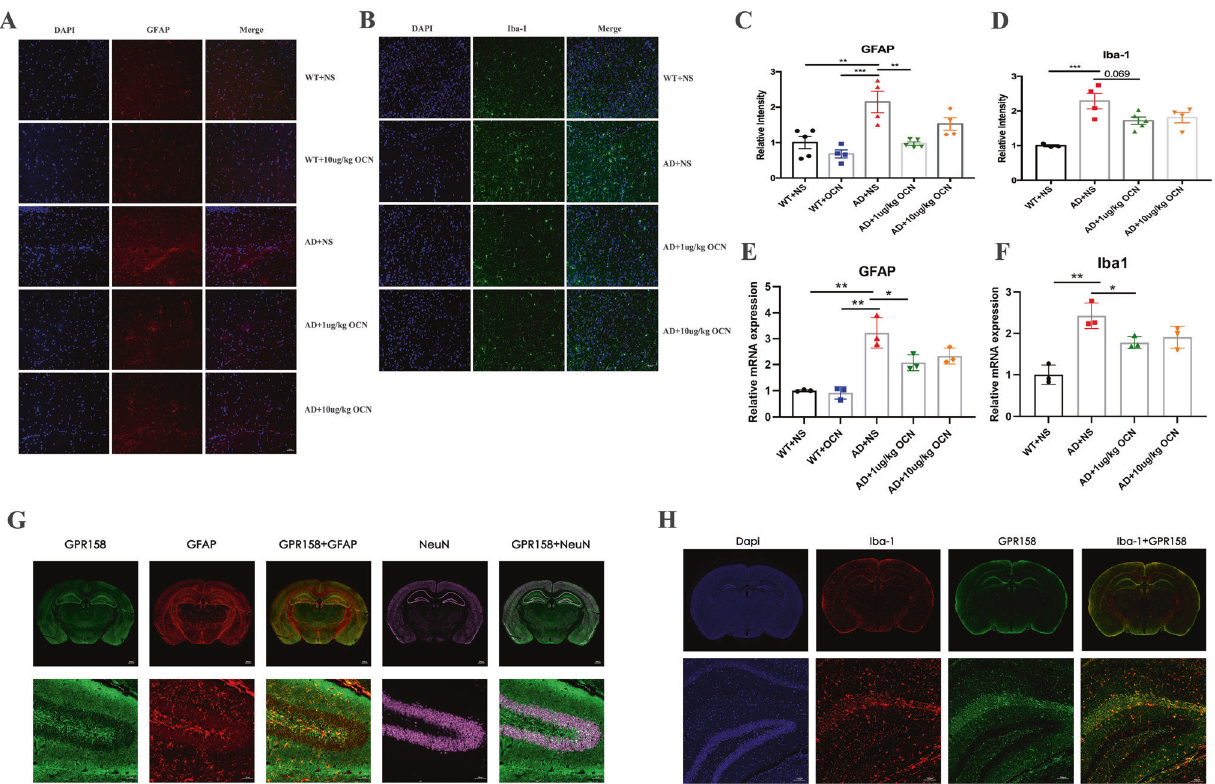
Fig. 4 OCN inhibited the proliferation of astrocytes in the hippocampus of AD mice, and Gpr158 is mainly co-localized with astrocytes in hippocampus. A Represent immuno fl uorescence showing GFAP in the hippocampus. B Represent immuno fl uorescence showing Iba-1 in the hippocampus. C Quantitation of relative GFAP-positive intensity in the hippocampus ( n = 4 – 5 per group). D the quantitation of relative Iba-1- positive intensity in the hippocampus ( n = 3 – 5 per group). E Relative mRNA expression of GFAP in the hippocampus ( n = 3 per group). F Relative mRNA expression of Iba-1 in the hippocampus ( n = 3 per group). G Gpr158 is co-localized with astrocytes in hippocampus. H Gpr158 is not mainly co-localized with microglia in hippocampus. All data represent the means ± SEM. A P -value < 0.05 was considered to